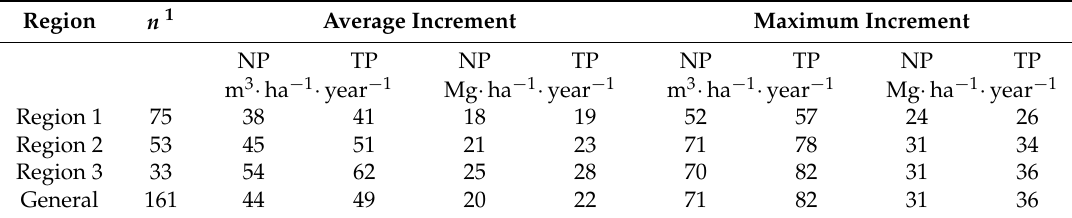
Table 4. The average and maximum annual increment at 7 years of age (MAI7) for twin and normal plots.